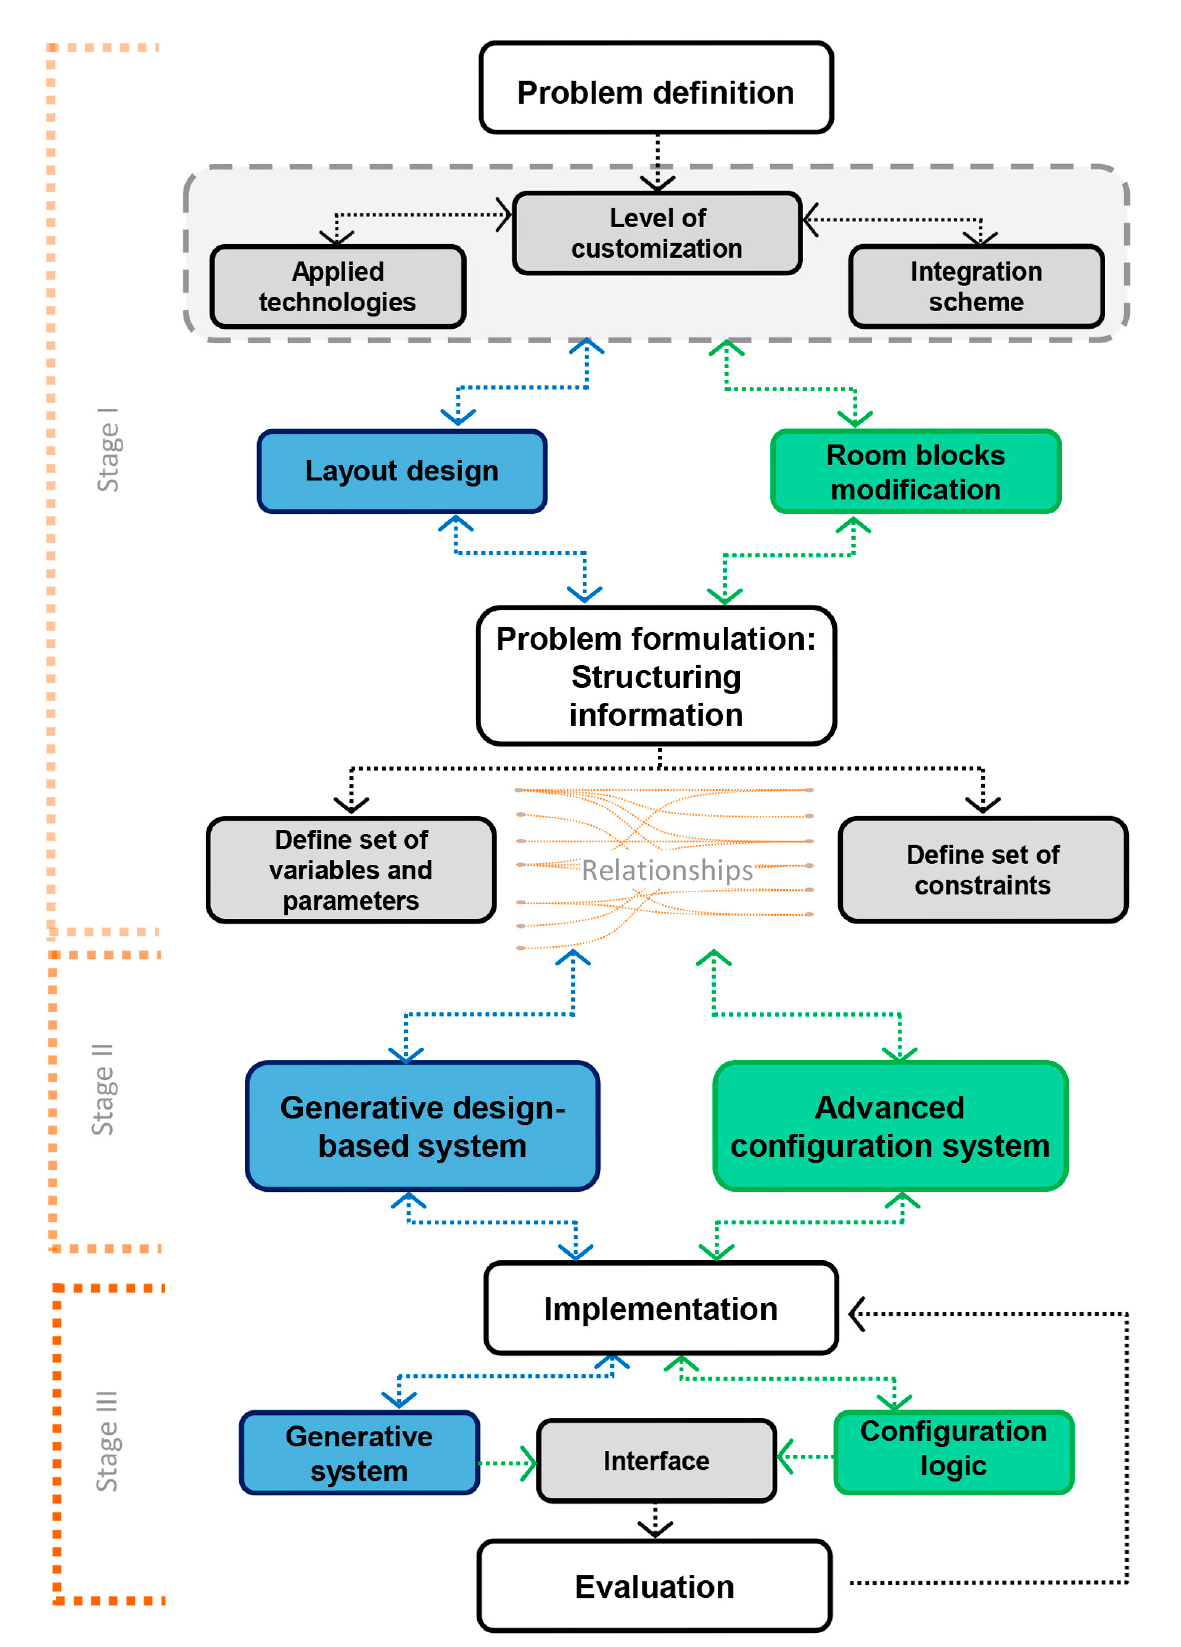
Figure 4. A diagrammatic representation of a proposed open framework for mass customization of housing.